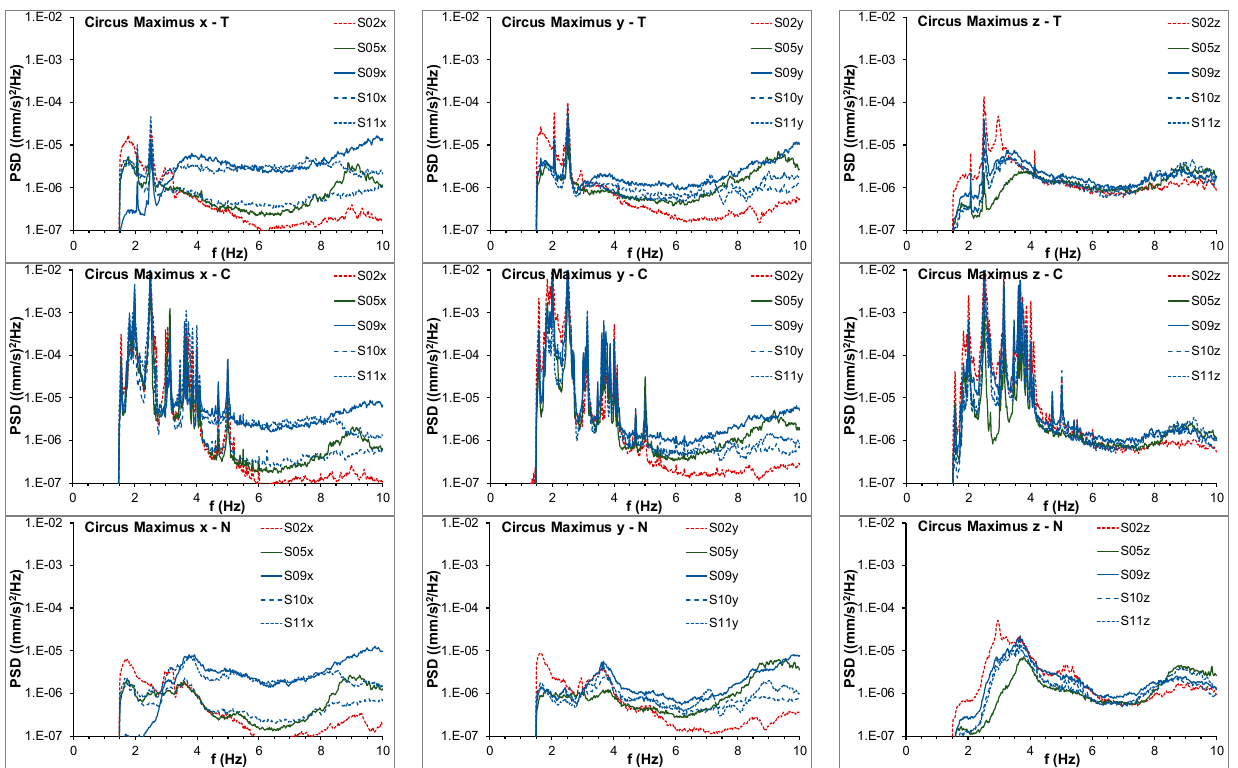
Figure 11. Circus: PSDs in the three directions for the three intervals. After the concert, in the presence of ambient noise only (N), amplifications are present between 1.5 and 4.0 Hz in all the three directions. Before the concert (T), the same resonance frequencies are apparent with higher amplifications, especially at 2.5 Hz. During the concert (C), several resonance frequencies between 1.5 and 5.0 Hz are apparent. The amplitudes in interval C are much higher than in the other intervals. It is evident that 2.5 Hz is the dominant frequency for all the directions, at all measurement points, even in the presence of traffic only. The spectral amplitudes become considerable during the concert. The rations between the spectra during T and N (Figure 12), and during C and N (Figure 13) confirm this consideration. Furthermore, the vertical component at the foot of the tower (S02x) is greater than the horizontal components (S02x and S02y). This resonance frequency does not seem to be linked to the characteristics of the soil, but is probably due to the presence of buried structures. The rotate spectrum analysis (Figure 14) helped to identify the angle of the maximum spectral amplitude, which remains unchanged during the three time intervals (T, C, and N).